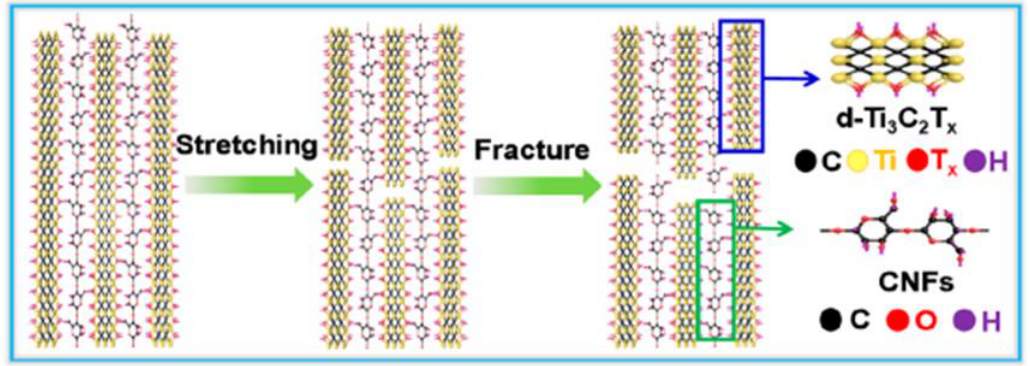
Figure 9. Interaction of the cellulose fiber with MXene and nacre−like structure formation [46] Copyright American Chemical Society, 2018.